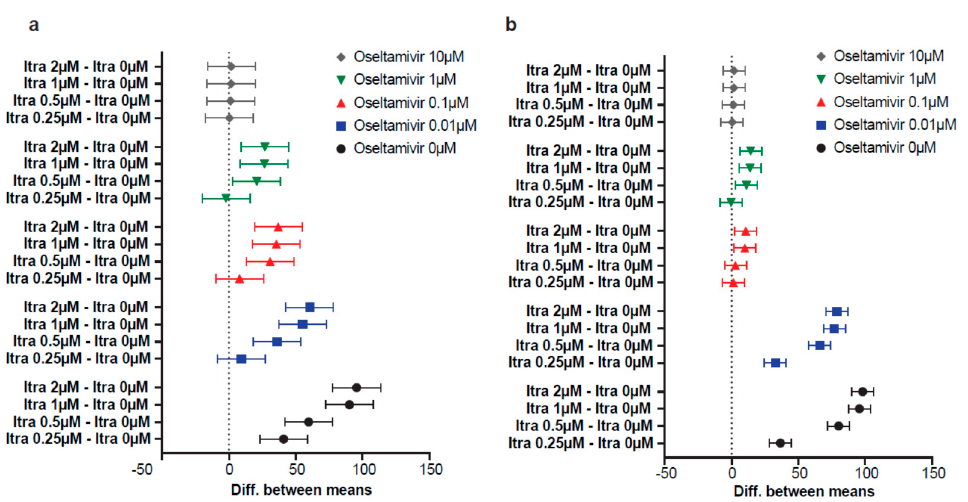
Figure 7. Analysis of the anti-IAV activity of combination treatments with oseltamivir and itraconazole. Polarized Calu-3 monolayers were infected with 0.1 MOI of ( a ) pdm09 or ( b ) Panama for 24 h. Oseltamivir and itraconazole were added at the indicated combinations 2 h p.i. For each oseltamivir concentration, mean percentages of reduction in viral titers ± SEM were compared to the respective oseltamivir treatment without itraconazole. Data are expressed as differences and 95% confidence intervals of the comparisons. Figure 8 summarizes the effects of combined treatments. Inhibition of at least 90% could be achieved with either oseltamivir and itraconazole single treatment. Combination treatments, except for the 10 µM oseltamivir treatment, the highest concentration used, tended to yield better inhibitory effects, and ≥ 90% inhibition already could be reached when 0.5 µM itraconazole was added to 0.1 µM oseltamivir (in case of pdm09) or when cells were treated with 1 µM oseltamivir (for both strains).